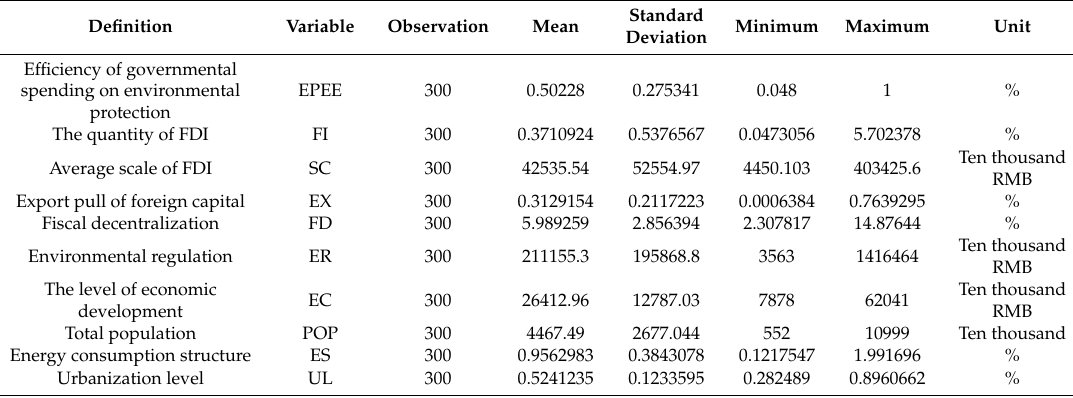
Table 2. Definitions and descriptive statistics of all variables in econometric